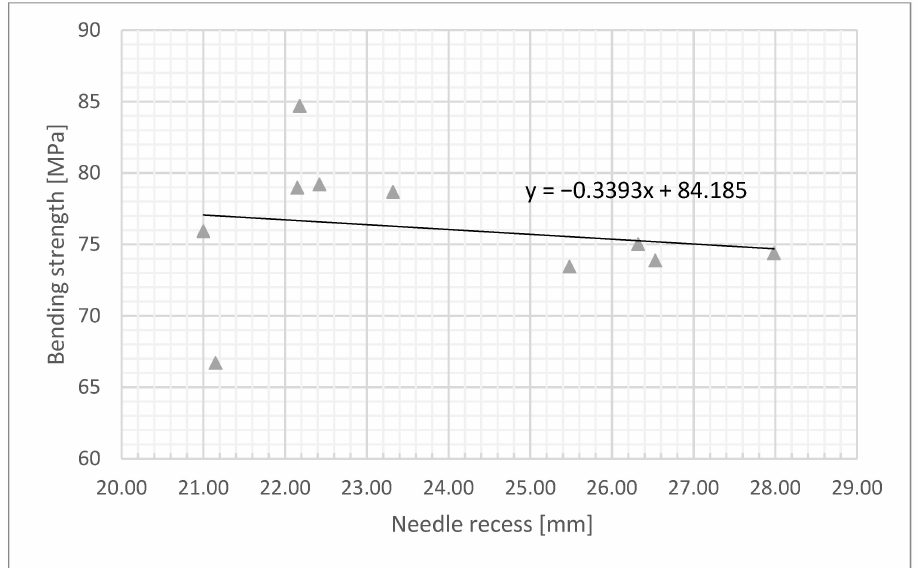
Figure 15. Correlation between the needle recess from the side of the element and its bending strength for spruce